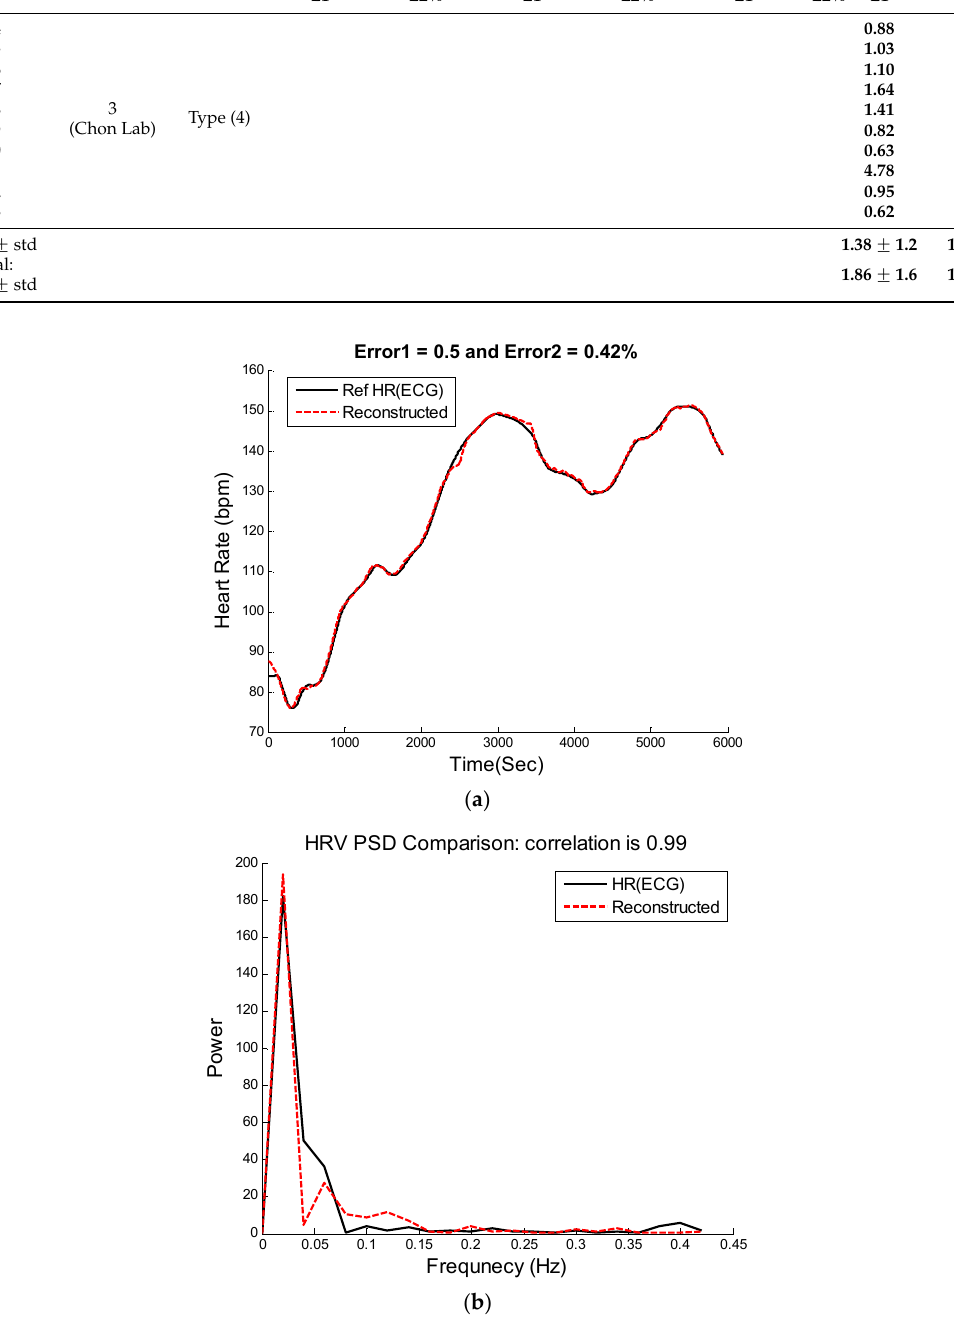
Figure 8. Subject 9 (IEEE Competition Training Dataset). ( a ) Reconstructed HR vs. reference HR; ( b ) Spectral comparison of reconstructed HR and reference HR (estimated from reference ECG).